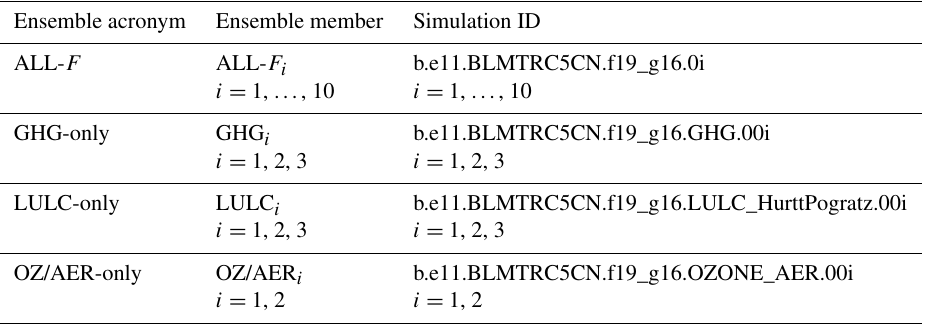
Table 3. Simulations used in this study are from the CESM-LME. The first and second columns present the acronyms used in this paper for ensembles and ensemble members, respectively. The ID of the original experiment files is provided in column